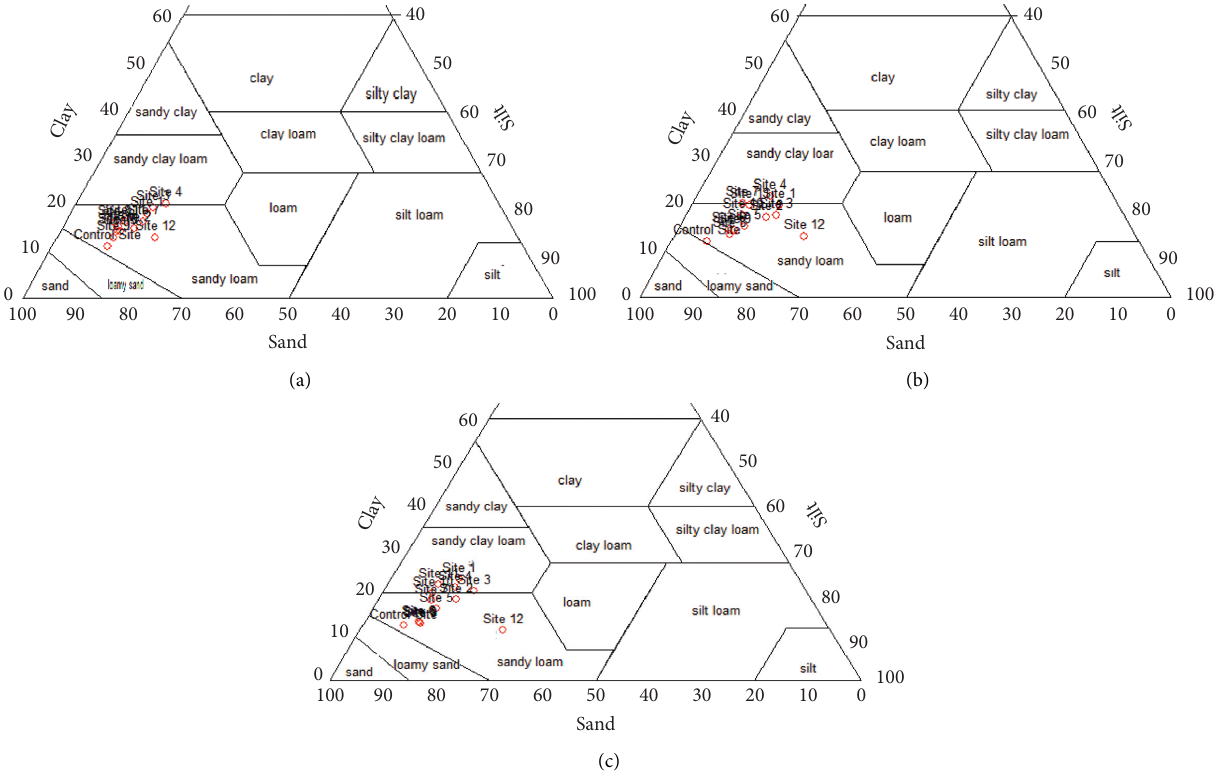
Figure 2: Textural triangles showing the texture of the soils at depths of 0–30cm (a), 30–60cm, (b) and 60–90cm (c) at the